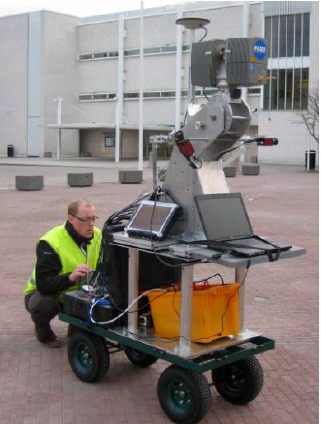
Figure 4. Initializing the cart carried MLS in urban